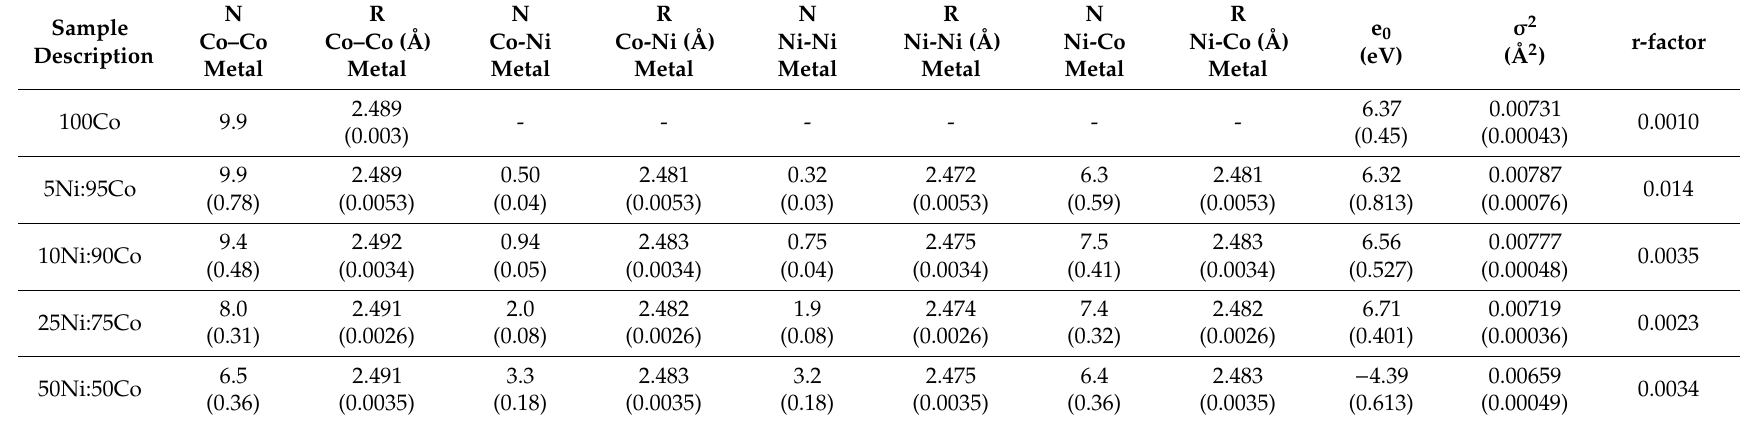
Table 3. Results of EXAFS fitting* for data acquired near the Co and Ni K edges for catalysts following TPR-EXAFS after cooling. The fitting ranges were ∆ k =